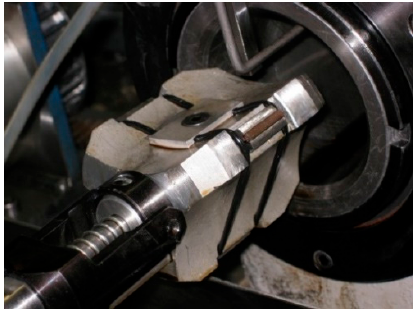
Figure 3. Honing head provided with cBN abrasive stones.